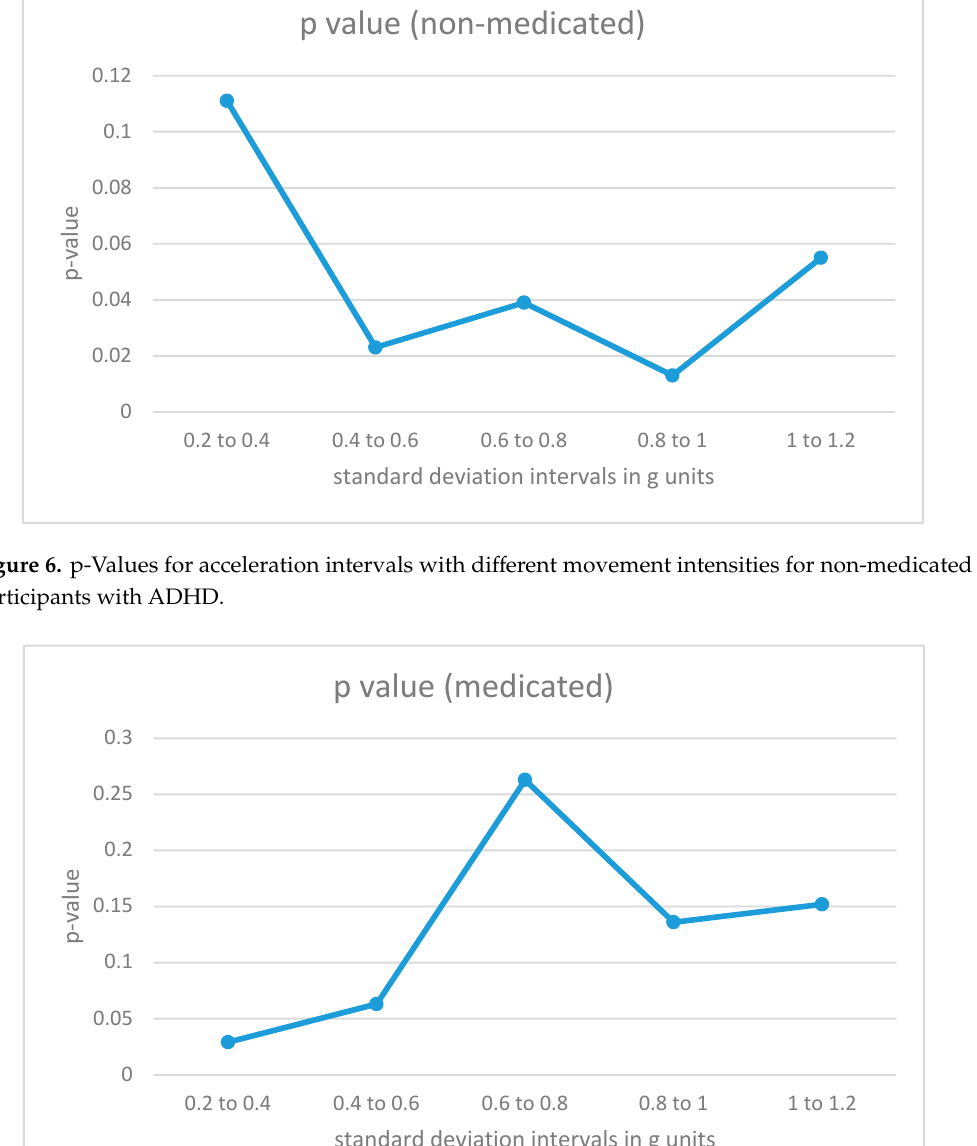
Figure 7. p-Values for acceleration intervals with different movement intensities for medicated participants with ADHD.